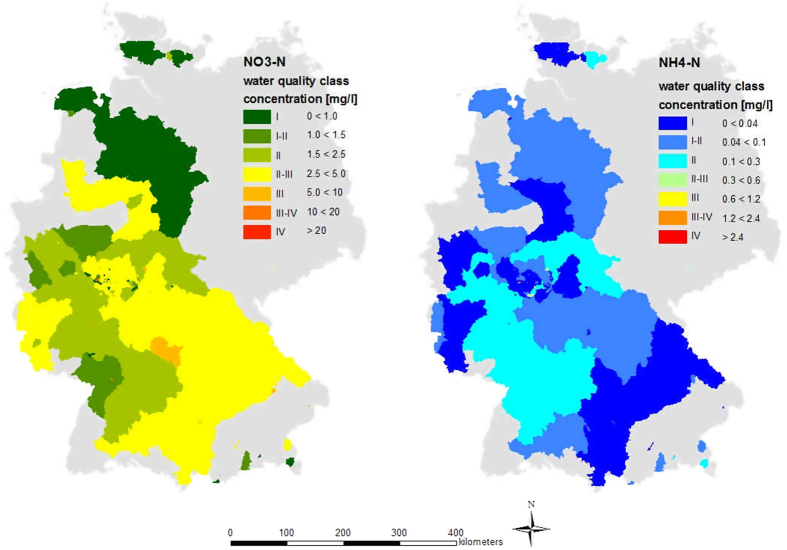
Nitrate and ammonium concentrations and respective water quality classes27 in the sampled catchments in Germany.Class I: no anthropogenic pollution, Class I-II: very low pollution, Class II: moderate pollution, Class II-III: significant pollution, Class III: increased pollution, Class III-IV: high pollution, Class IV: very high pollution. Maps were generated with ArcGIS 10.0, ESRI.